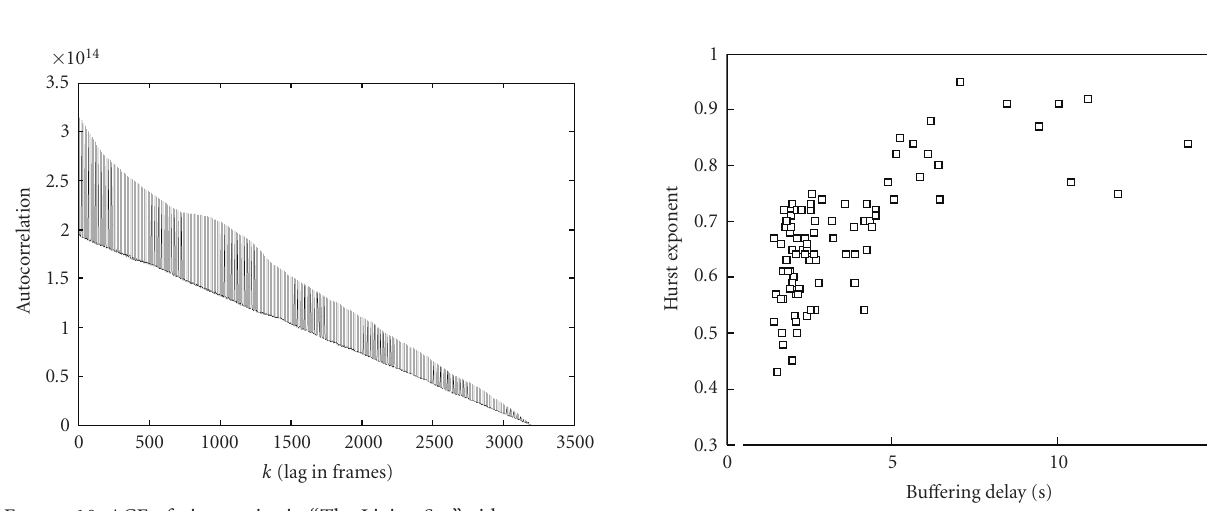
ff ering delay in real tra ffi cs.